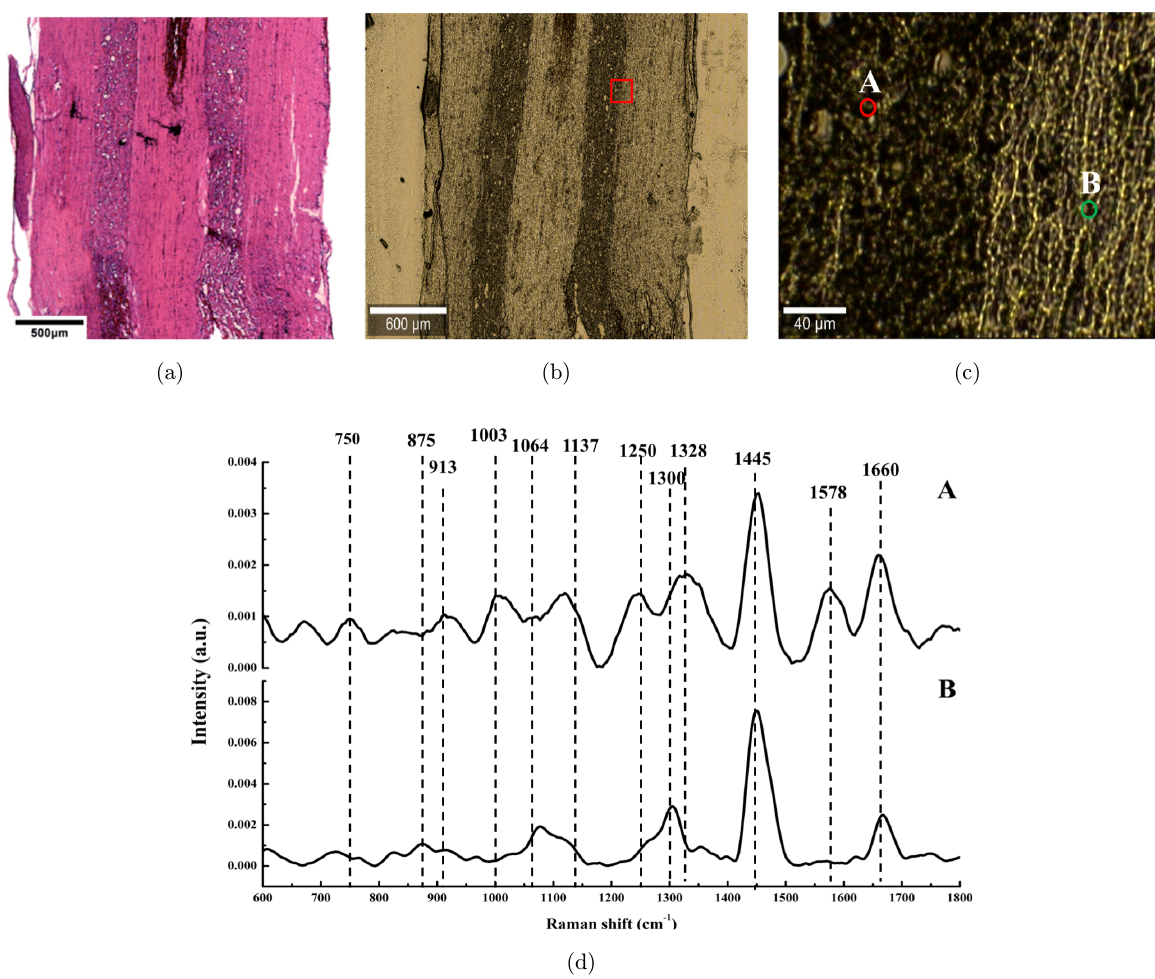
Fig. 2. The microphotograph of a longitudinal H&E-stained spinal cord section with 500 (cid:1) m scale bar (a); a stitched bright-¯eld microscopy image of the longitudinal section in 3 (cid:3) 2 mm 2 with 600 (cid:1) m scale bar (b); a microscopic image with 40 (cid:1) m scale bar (c) and the normalized spectra from both gray and white matter (d). The red square in (b) is the localization where the microscopic image (c) recorded. And the green and red circles in image (c) are the spectra acquiring points. Table 1. Band position and assignments of selected Raman peaks from mouse spinal cord tissue from 600 to 1800 cm (cid:1) 1 . Peak position (cm (cid:1) 1 ) Assignments Chemical